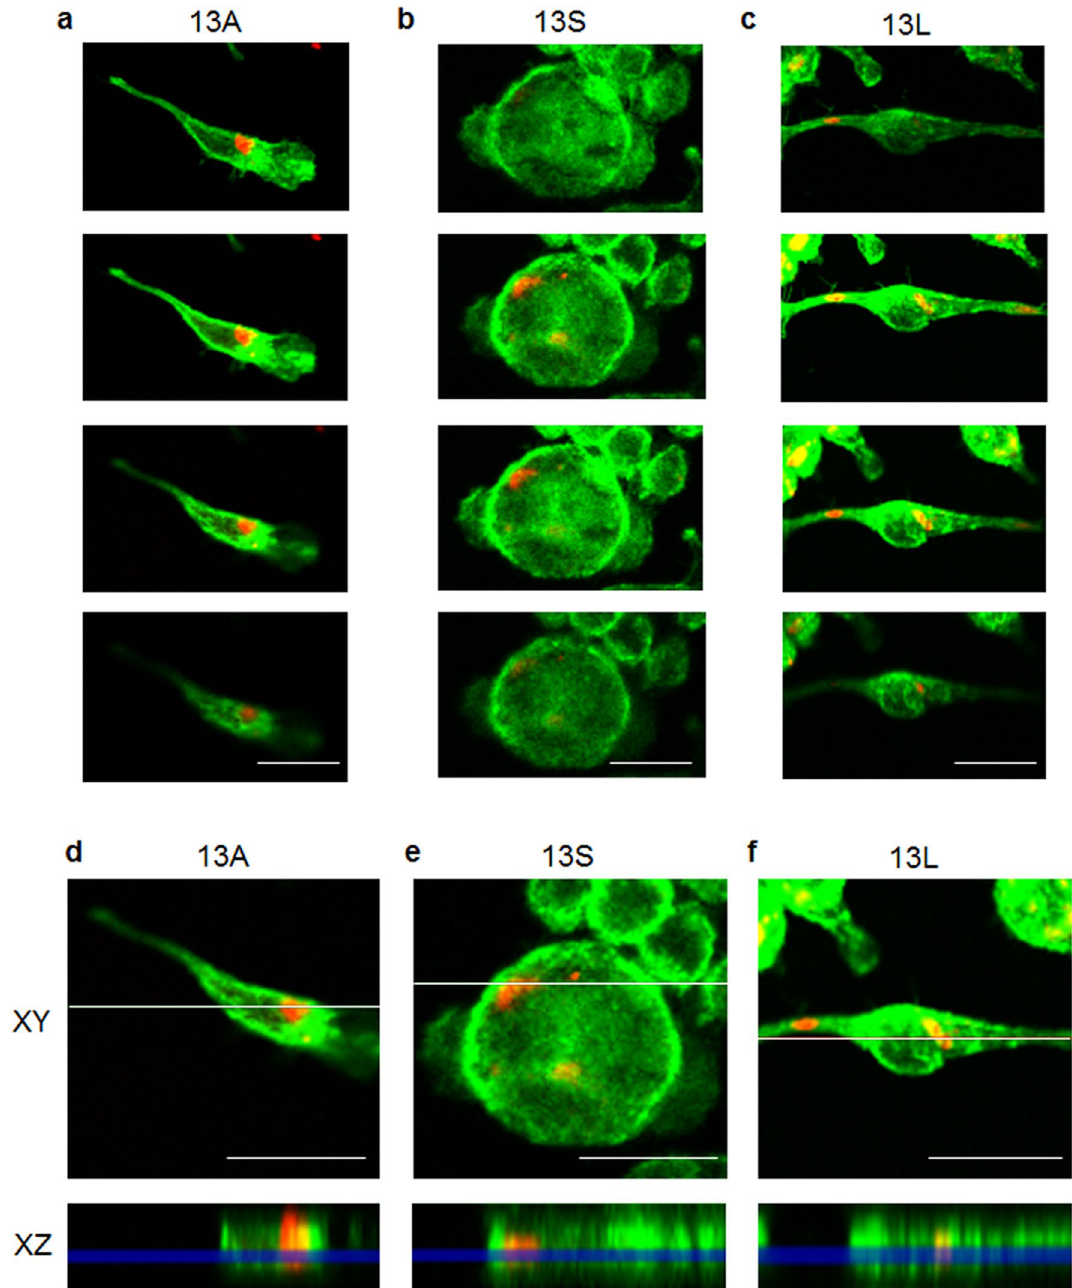
Figure 1. Aggregated 13A, 13S and 13L are incorporated into BV2 microglia cells. Fluorescence z-stack images of BV2 microglial cells with 13A ( a , d ), 13S ( b , e ) and 13L ( c , f ) using confocal laser scanning microscopy. ( a – c ) The serial section images of cells having 13A ( a ), 13S ( b ) and 13L ( c ) taken at every 1 µm are shown. ( d – f ) Ortho images constructed from the z-stacks. The XZ-axis cross section images (bottom) along the white line in the XY-axis view (top) are shown. 13A ( d ), 13S ( e ) and 13L ( f ) signals (red) are found between cytoplasmic phalloidin signals (green) in the XZ-axis view. Scale bar 20